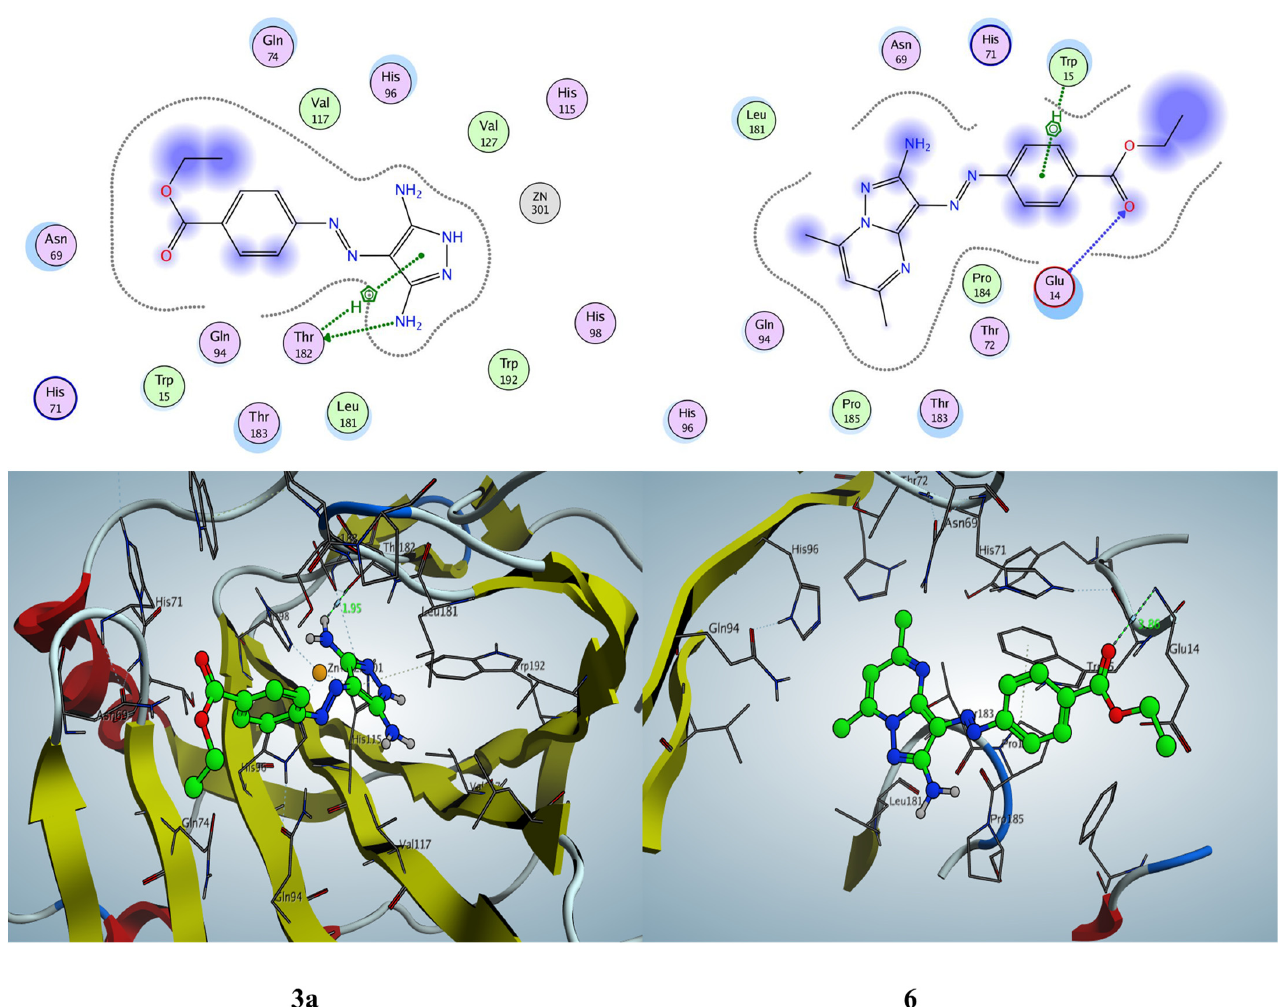
Figure 13. 2D and 3D enzyme–ligand interaction of compounds 3a and 6 inside the active site of alpha CA (PDB: 5HPJ) .